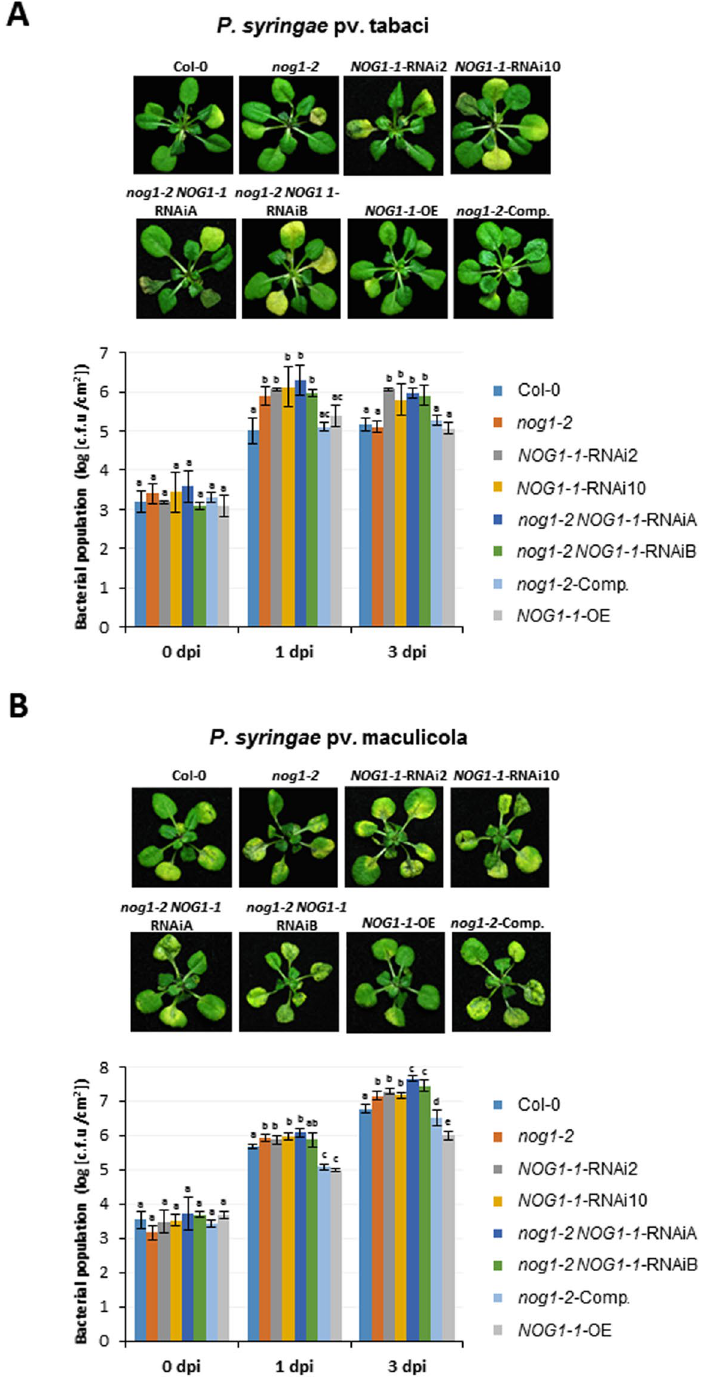
Figure 4. Arabidopsis NOG1-1- RNAi but not nog1-2 plants are compromised in nonhost resistance. ( A , B ) Arabidopsis wild type (Col-0), nog1-2 knockdown line, NOG1-1- RNAi, nog1-2 NOG1-1- RNAi double-gene knockdown lines, overexpression ( NOG1-1-OE ) and complementation lines ( NOG1-2 -comp) were flood- inoculated with Pstab (1.4 × 10 6 CFU/ml) (A) or Psm (1 × 10 4 CFU/ml) ( B ) to assess disease symptoms (upper panel) and bacterial growth (lower panel) at 1 and 3 days post inoculation (dpi). Different letters above bars indicate a statistically significant difference within a time point using two-way ANOVA ( P < 0.01). Error bars represent the standard deviation of three biological replications (three technical replicates for each biological replication). All experiments were conducted using T2